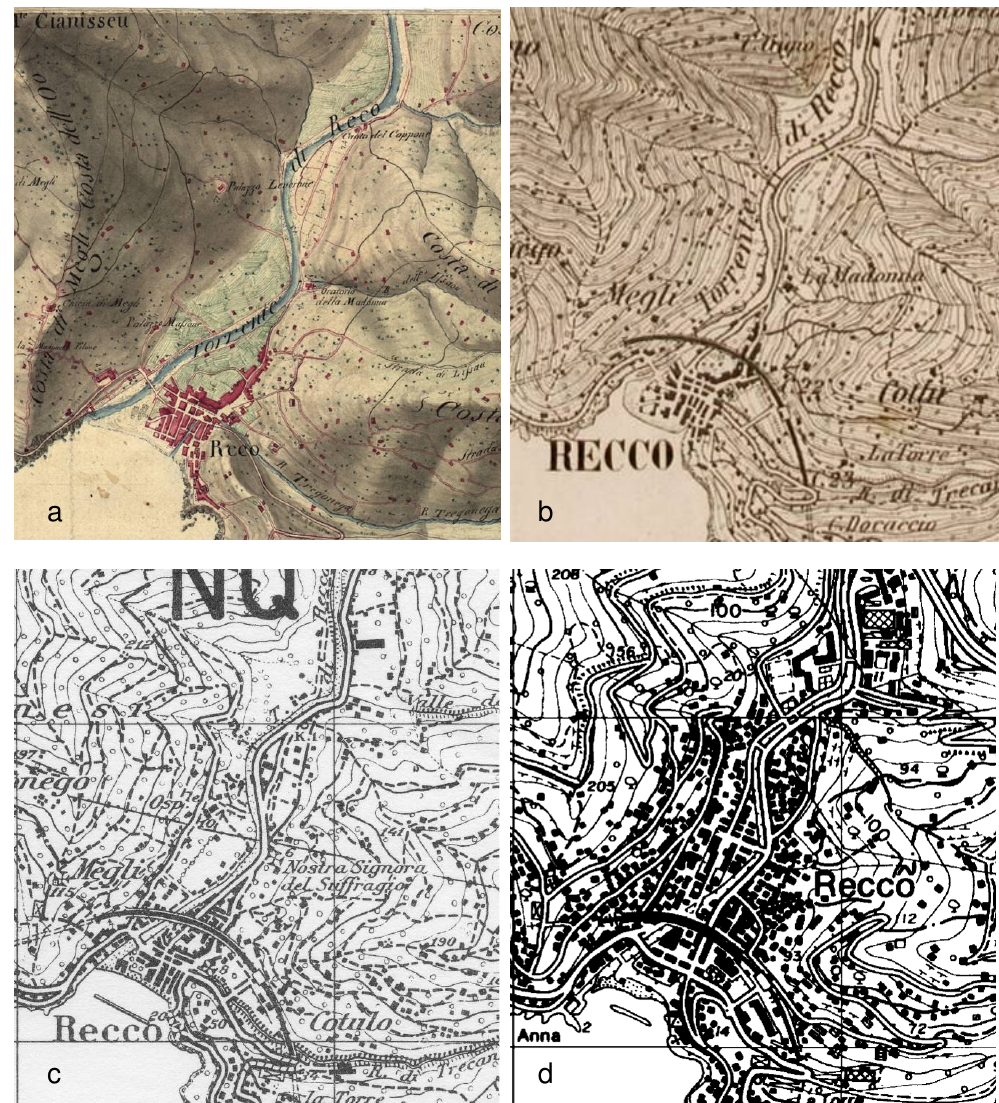
Fig. 9. Topographic map of Recco Stream floodplain: (a) 1815–1823 (“Carta degli Stati Sardi di Terraferma”), (b) 1878 and (c) 1936 (“Tavolette serie 25v dell’Istituto Geografico Militare Italiano), (d) 1996 (Carta Tecnica Regionale).